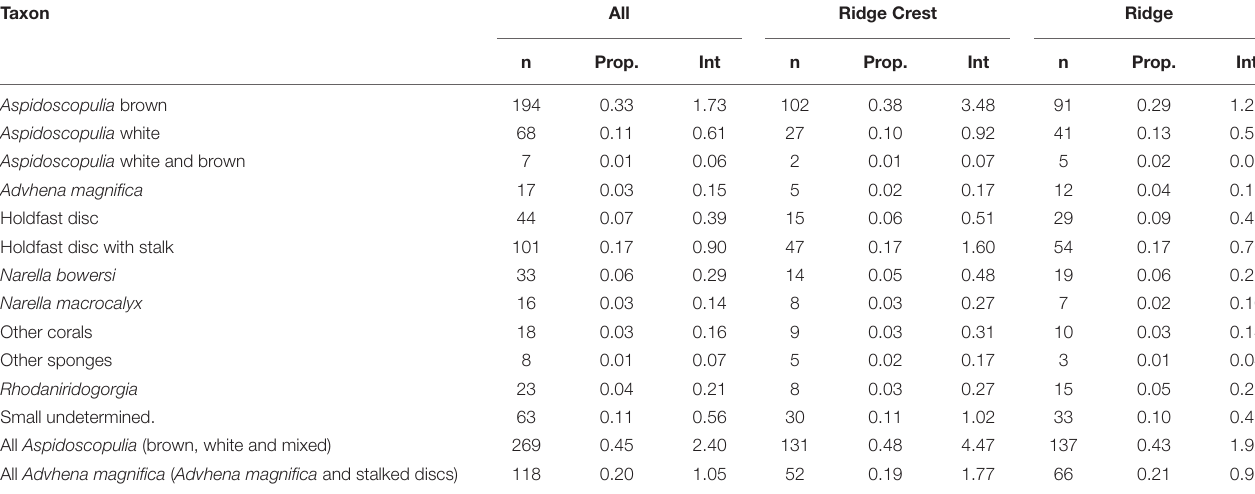
TABLE 1 | Summary table.